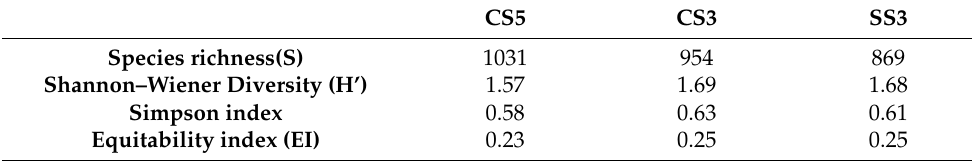
Table 1. Estimates of relative diversity based on the 16S rDNA PhyloChip